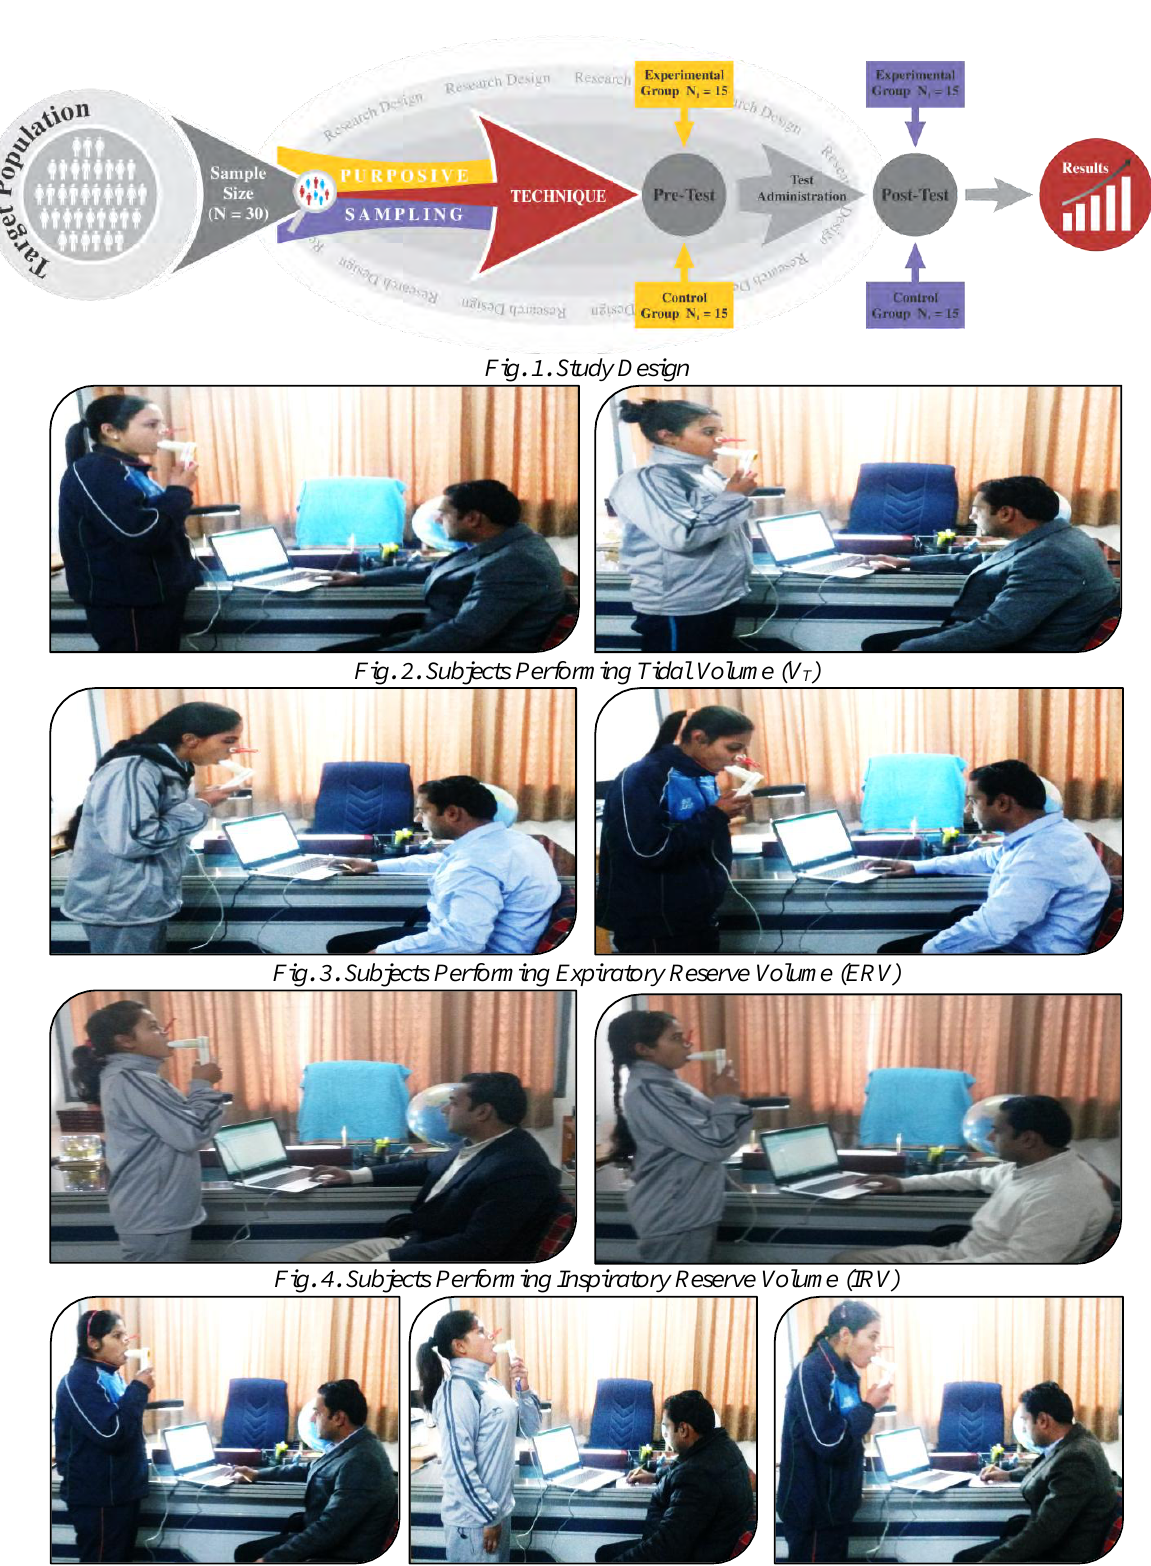
Fig. 5. Subjects Performing Vital Capacity